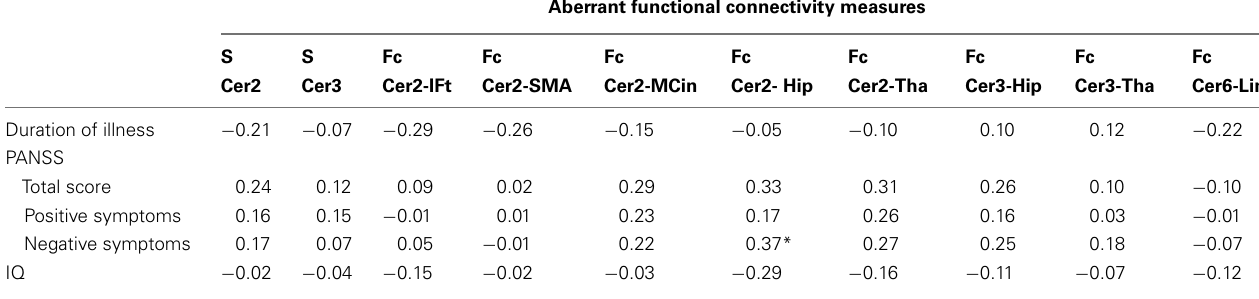
Table 4 | Clinical correlates of aberrant functional connectivity